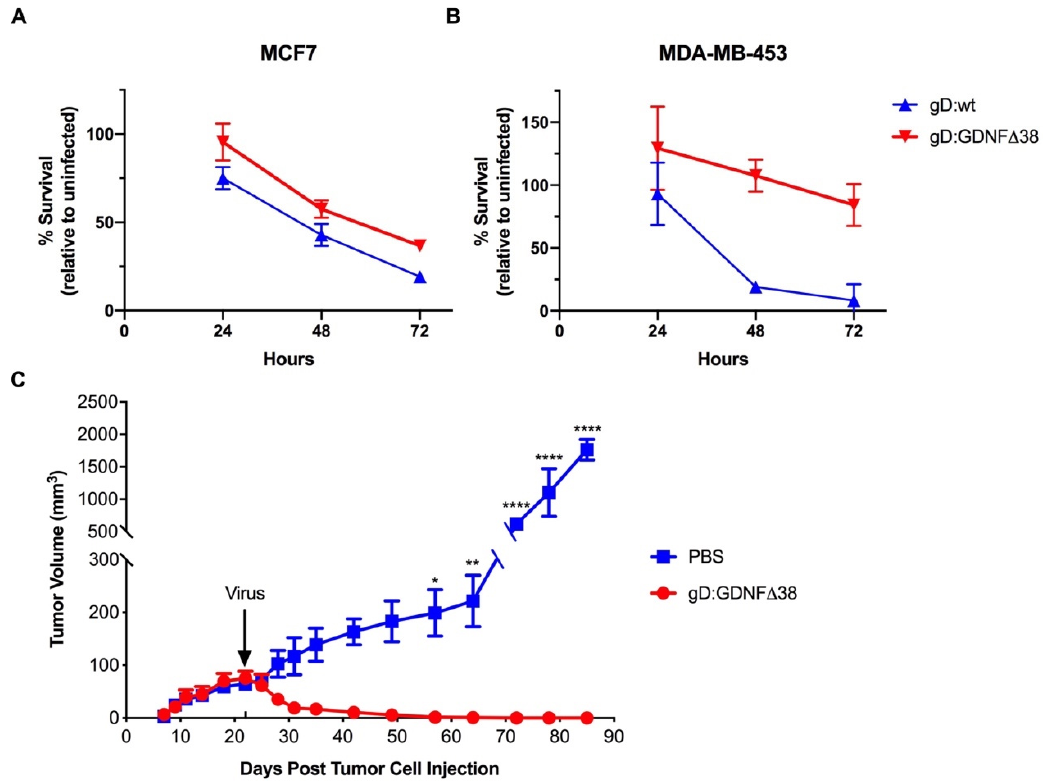
Figure 6. Virus-mediated cell death in vitro and tumor treatment. ( A ) MCF7 or ( B ) MDA-MB-453 cells were infected with KNTc-gD:GDNF ∆ 38 or KNTc-gD:wt virus at 3 pfu / cell and cell viability at 24, 48 and 72 hpi was measured by alamarBlue assay. Data are presented as the percentage of viable cells relative to uninfected cells at each time point. Averages presented at each time point represent 5–8 independent infections ± SEM. Statistics were determined by two-way ANOVA comparing virus infected cells to uninfected control cells at each time point. At 48 and 72 hpi, the viability of MCF7 cells infected with KNTc-gD:wt and KNTc-gD:GDNF ∆ 38 was significantly reduced compared to uninfected cells (KNTc-gD:wt, p < 0.0001 at 48 and 72 hpi, and KNTc-gD:GDNF ∆ 38, p = 0.0003 at 48 hpi and p < 0.0001 at 72 hpi). At 72 hpi, the viability of MDA-MB-453 cells infected with KNTc-gD:wt